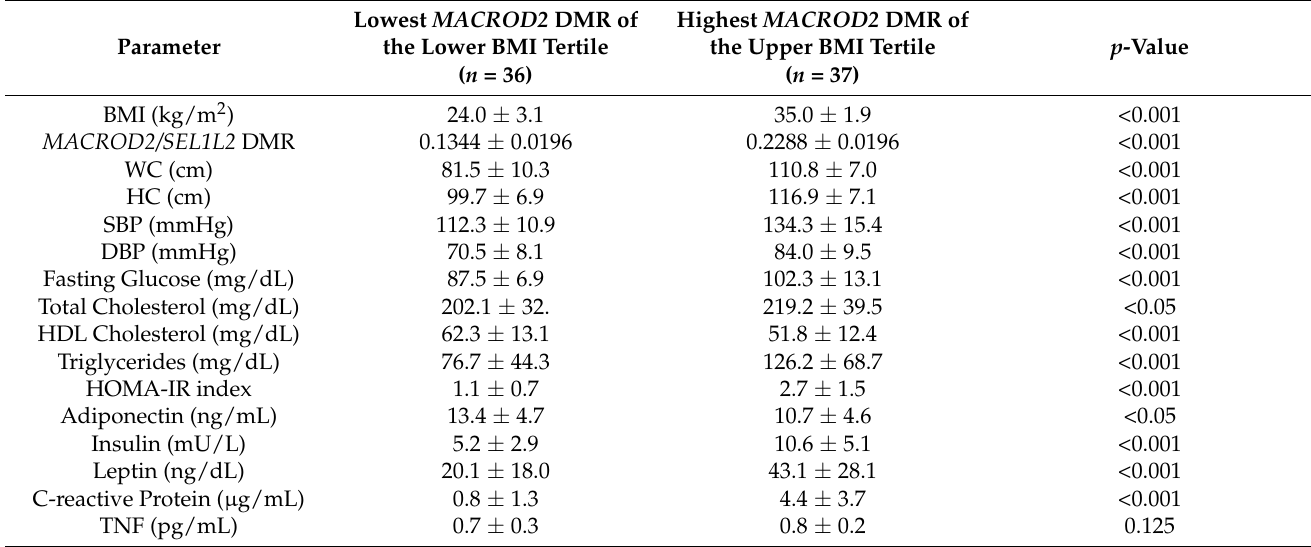
Table 4. Anthropometric and clinical data of the study population for MACROD2 protein quantifica- tion according to MACROD2 DMR levels in the higher and lower BMI tertiles.